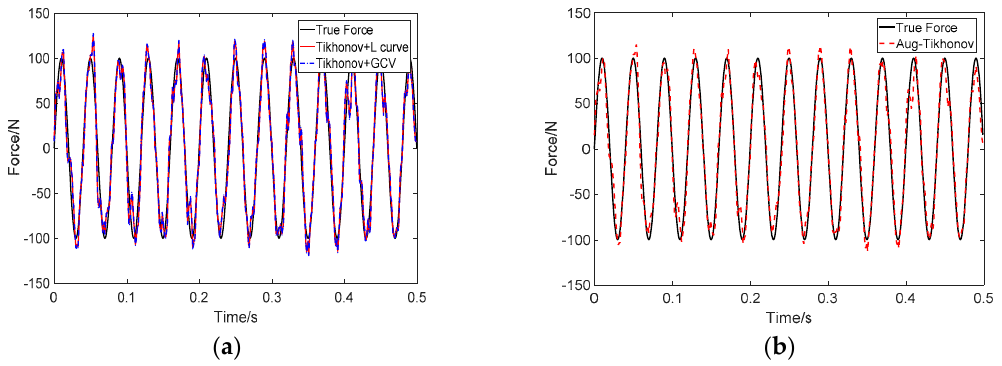
Figure 7. Identification result of sinusoidal load at SNR 20 dB: ( a ) Tikhonov method; ( b ) the proposed method.